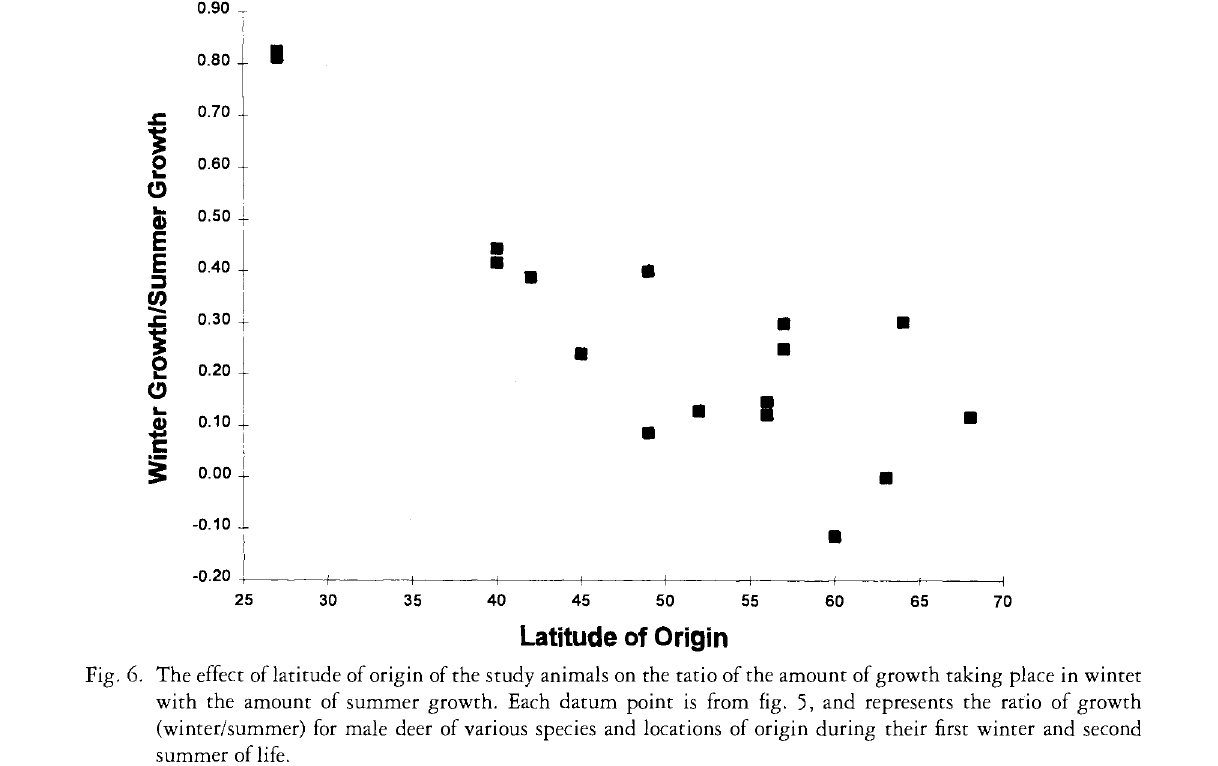
Fig. 6. The effect of latitude of origin of the study animals on the tatio of the amount of growth taking place in wintet with the amount of summer growth. Each datum point is from fig. 5, and represents the ratio of growth (winter/summer) for male deer of various species and locations of origin during their first winter and second summer of life.